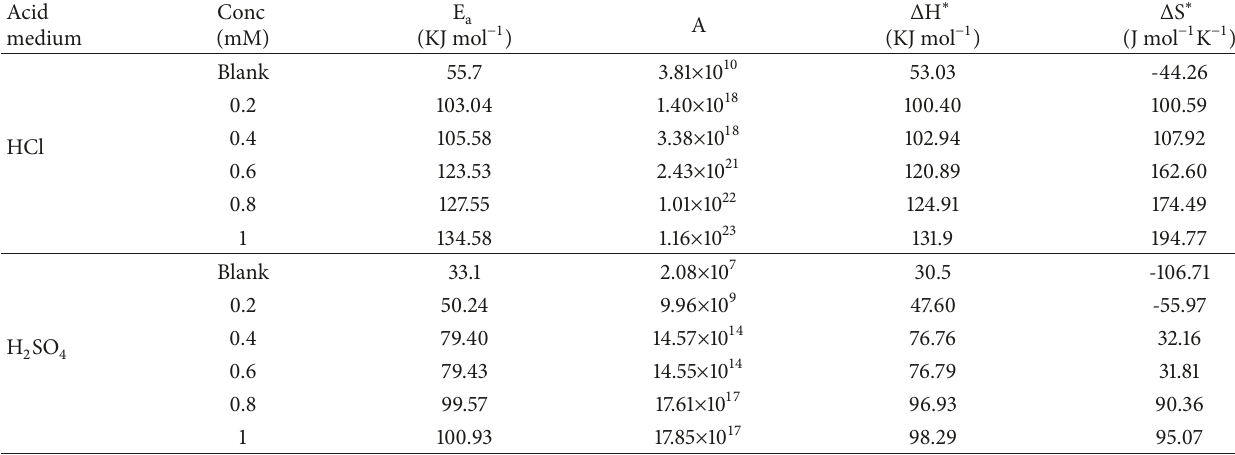
Table 3: Thermodynamic parameters of corrosion of MS with and without DmChDp in 1M HCl and 0.5M H 2 SO 4 . Acid